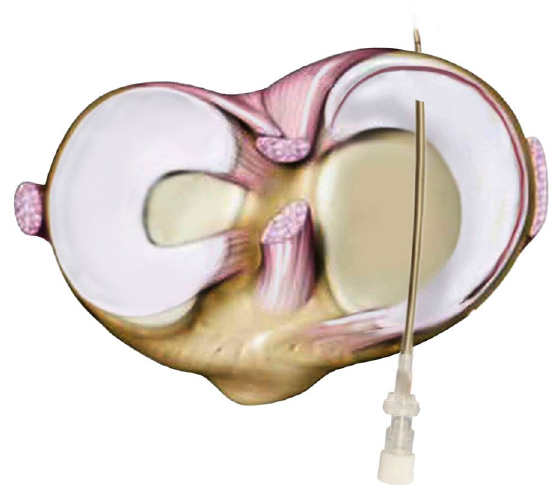
Fig. 2 Percutaneous provisional fixation in a right knee using a prebent needle inserted from anterior to posterior, perpendicular to the meniscal